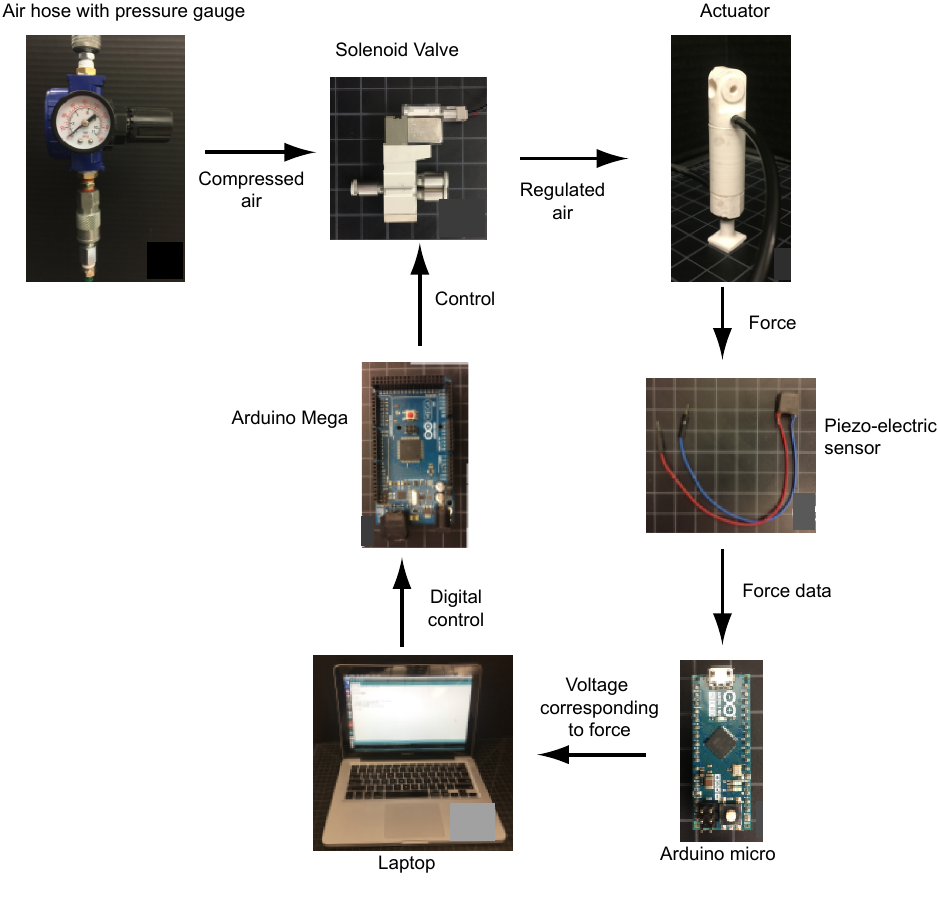
Figure 6. Experimental setup for testing the pneumatic actuator.